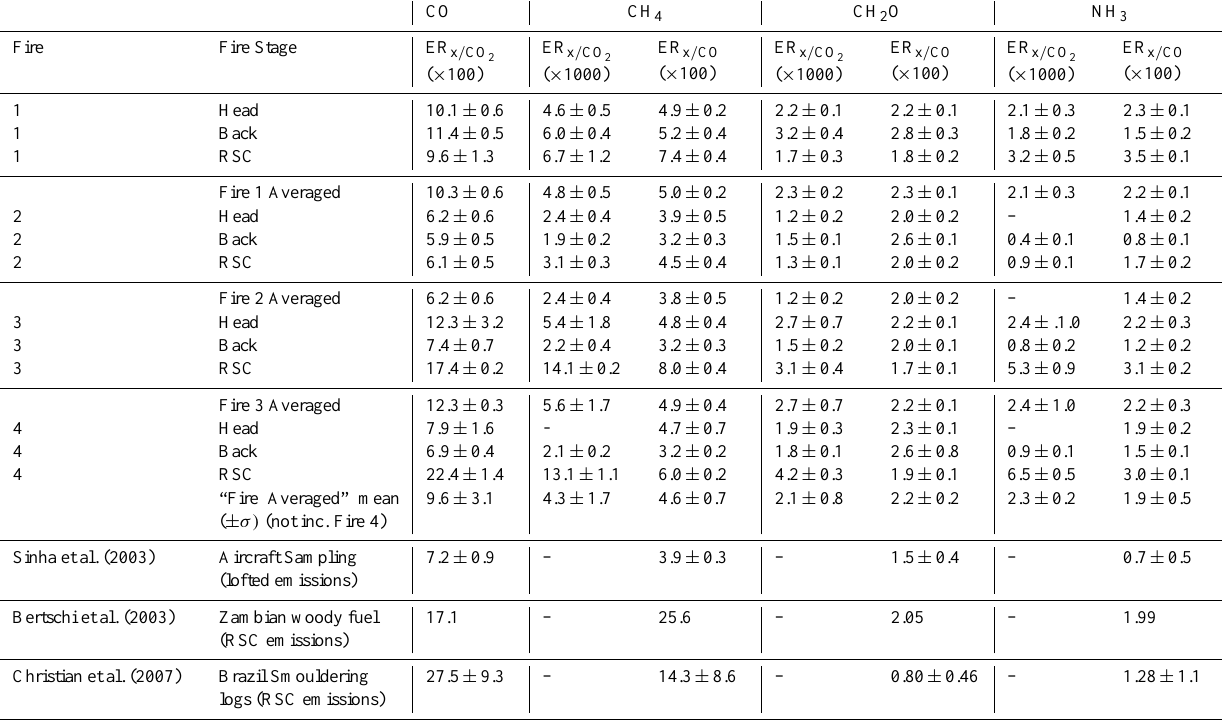
Table 3. Molar emission ratios and associated uncertainties for compound x with respect to both CO (ER x / CO ) and CO 2 (ER x / CO reported for the backfire, headfire and residual smouldering combustion (RSC) stages of Fires 1 to 4 and calculated using methods described in Sect. 4.2. Poorly constrained ERs [those with r 2 lower than 0.4] are not reported here. “Fire averaged” ERs are calculated using stage- specific ERs weighted by the FRE-determined proportion of fuel burned in each stage (apart from for Fire 4 where FRE data are unavailable). Uncertain ERs for the RSC stage do not prevent calculation of fire averaged values, since an insignificant amount of fuel is burned in this fire stage (Table 1). Final three rows show the mean ER x / y ± 1 σ calculated from the available fire averages, results for the same study area derived via aircraft sampling of lofted emissions by Sinha et al. (2003), and results from the study of Bertschi et al. (2003) where the ER’s for a group of tropical wooded savannah logs from Zambia were measured whilst undergoing residual smouldering combustion